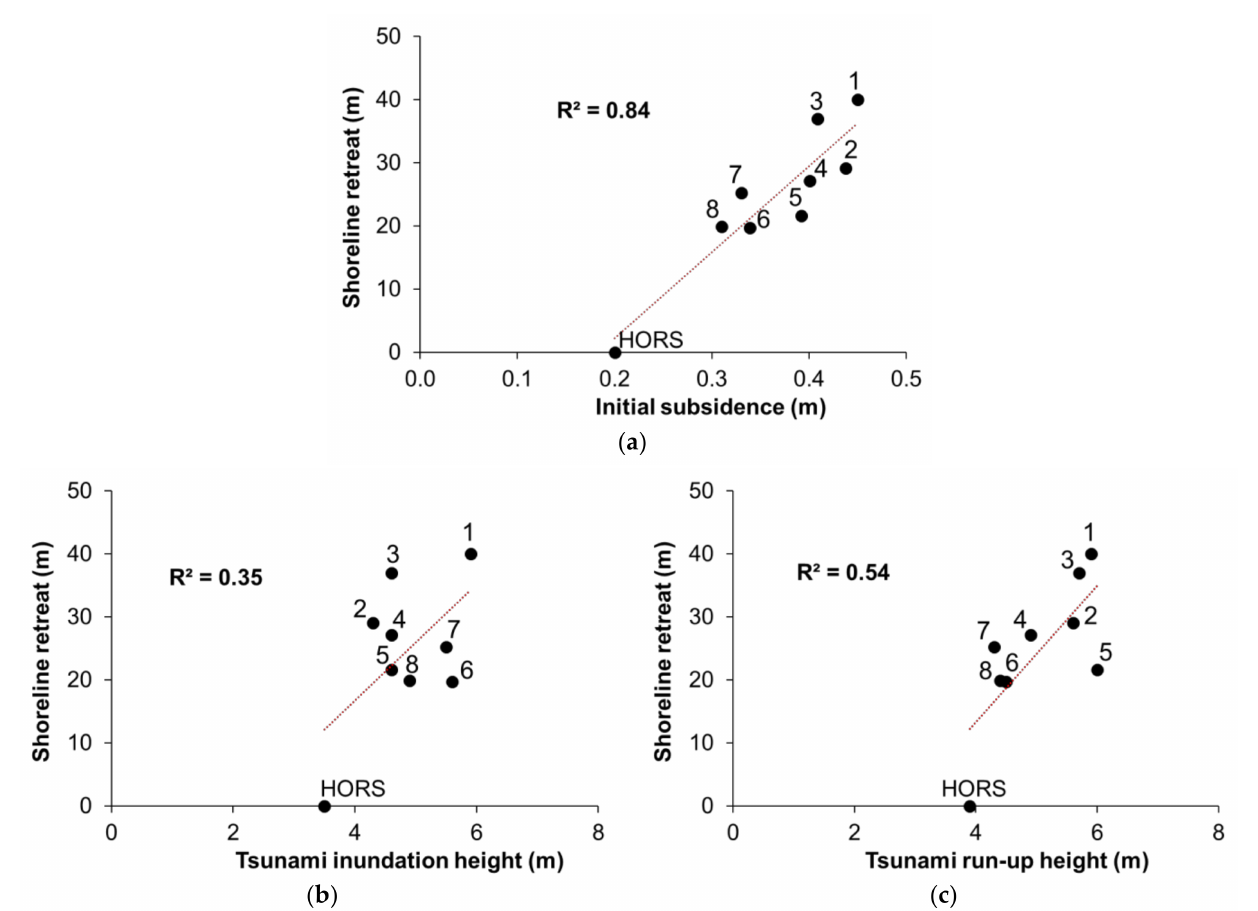
Figure 7. ( a ) Sudden shoreline retreats due to initial subsidence caused by the earthquake. Data at Hasaki Research Pier (HORS) were used in the regression procedure because the beach is sandy, with available information about initial subsidence, tsunami height, and land uplifting rate. ( b , c ) Correlation between amount of sudden retreat and tsunami inundation height and tsunami run-up height. Number in the circle denotes sandy beach, and the radius of the circle is proportional to the amount of